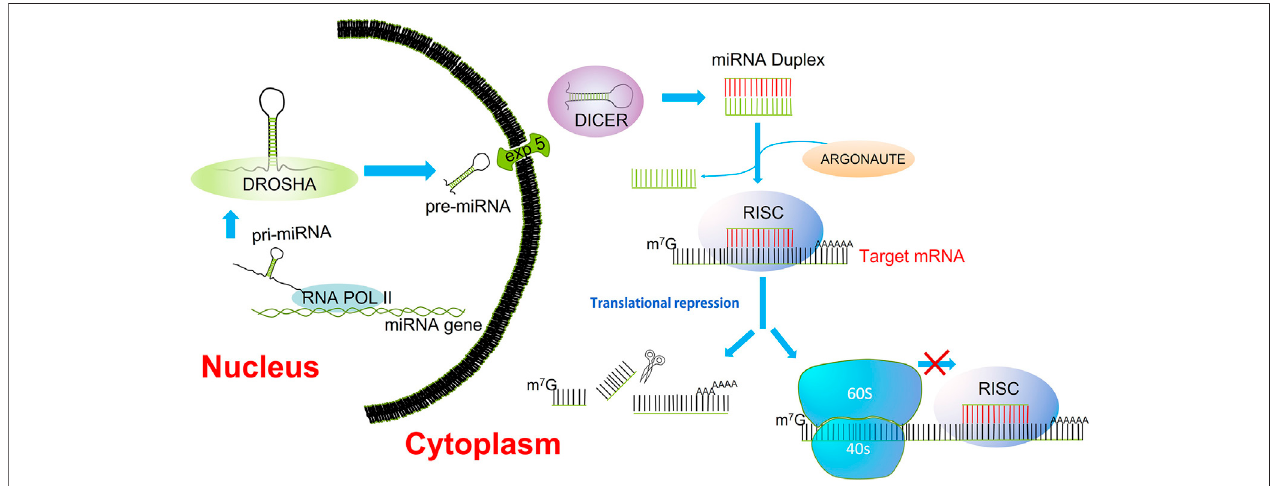
FIGURE1| miRNAbiogenesis.TranscriptionofmiRNAsismediatedbyRNApolymeraseII.Thepri-miRNAsaresubstratesforthernaseIII,Drosha.Theproductof pre-miRNA cleavage by Drosha is exported to the cytoplasm by the nuclear transporter exportin 5. In the cytoplasm, DICER processes the pre-miRNA into a miRNA/ miRNA* duplex. Final processing yields the mature miRNA duplex, the strand with lower thermodynamic stability is loaded into Argonaute (AGO); this is deemed the guide strand. The guide strand alongside AGO constitutes the minimal RNA-induced silencing complex (RISC). Once recruited the RISC complex onto the mRNA target, the inhibition of translation is carried out through cleavage, deadenylation, or blocking of the mRNA translation.